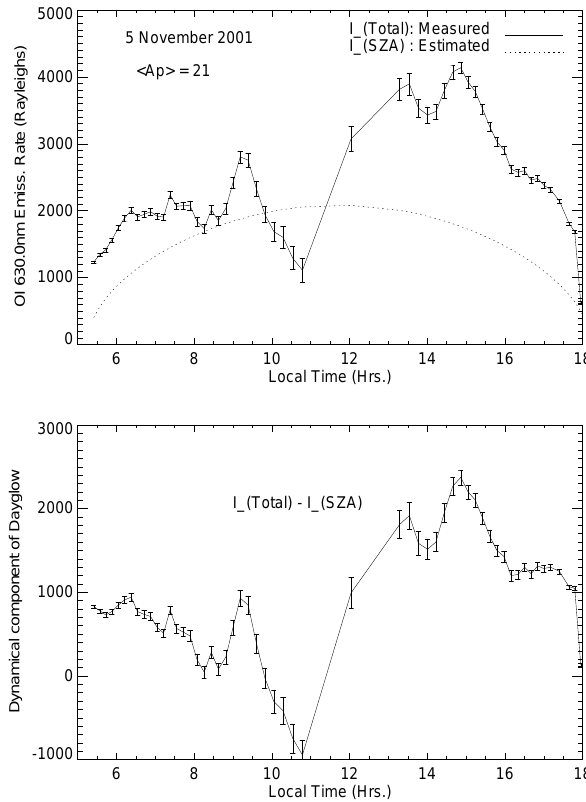
Fig. 2. (Top): Zenith column-integrated OI 630.0nm dayglow emission rate from Carmen Alto (solid line) and the solar zenith angle (dotted) contribution for 5 November 2001 are depicted along with ± 1 σ error bars. The x and y axes represent the local time and the column-integrated emission rate in Rayleighs. The SZA depen- dent dayglow contribution is obtained by assuming a (cosine) 0 . 5 behavior for this variation with SZA and normalizing it with the measured dayglow emissions at around 07:30 LT. The value of the averaged A p index for the day is shown on top left. (Bottom): Difference between the total column-integrated dayglow emissions and SZA component of the dayglow. This represents the dynamical component in the optical emissions. The negative values represent the “trough-like” features of the wave features. Attention should be paid mainly to the amplitudes of the wave features and not to the negative or positive values alone. A monotonic increase is seen towards afternoon, which is a response of the EIA